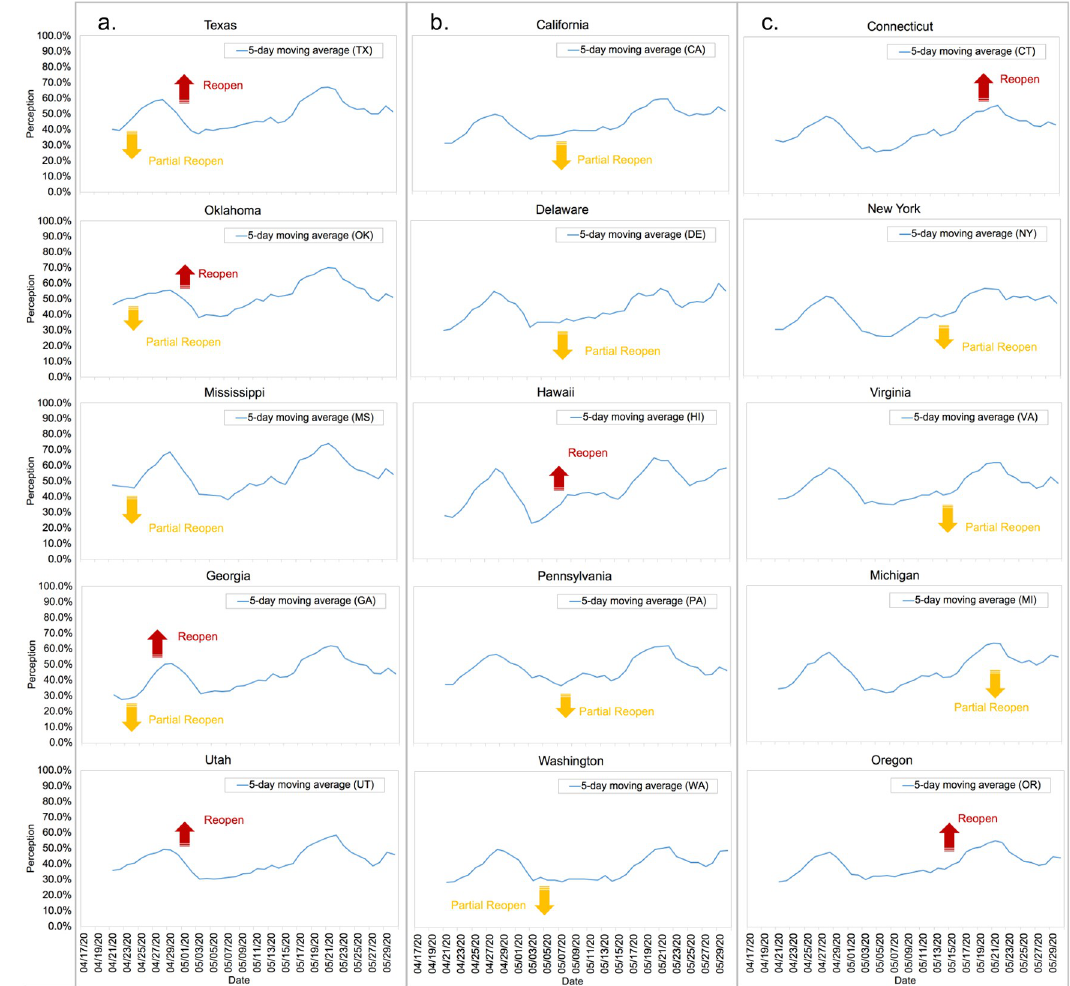
Fig 4. The impact of reopening policy on perception level. a. Group a: first mover (partially reopen or fully reopen before May 5). b. Group b: follower (partially reopen or fully reopen between May 5 and May 14). c. Group c: late mover (partially reopen or fully reopen after May 14). The upward arrow corresponds to the time of full reopen, and the downward arrow corresponds to the time of partial reopen. For the “first mover” group, the pattern manifests that, for 10 out of 21 states, the percep- tion emerged on Twitter supported an early partial reopening policy (allowing some major sectors to reopen) but adversely reacted to a full early reopening policy (allowing every major sector to reopen). One possible explanation is that Twitter users were aware of the risks of increasing cases that might result from an early full reopening policy even though such policy aimed to reinvigorate a slumping economy. Moreover, 8 out of 21 states in the “first mover” group reacted negatively even to an early partial reopen, while only 3 out of 21 states (“AL,” “NE,” and “ND”) displayed a positive reaction to a fully early reopening policy. For the “fol- lower” group, the observed pattern appeared to be consistent. A neutral or slightly positive reaction to reopening policies was reported from 16 out of 17 states in this group excepting “NV” state where an adverse reaction was observed. For the “late mover” group, the overall response was positive. 14 out of 19 states in this group showed a positive sentiment on the